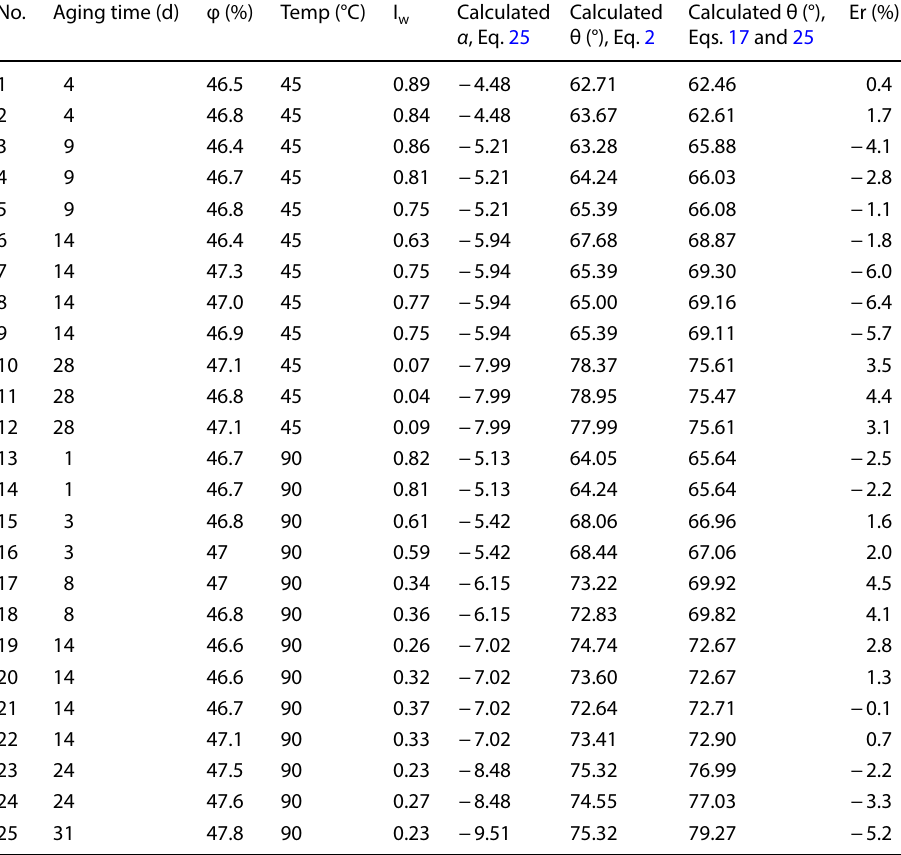
Table 2 Measured wettability indices of outcrop chalk samples from the Rørdal quarry